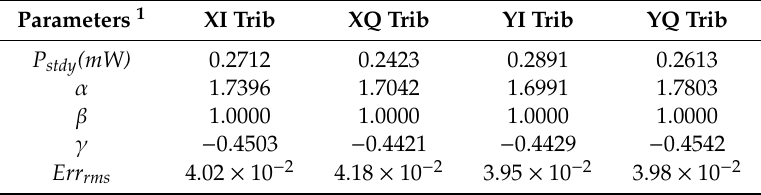
Table 1. Fittings parameters for four tributaries.